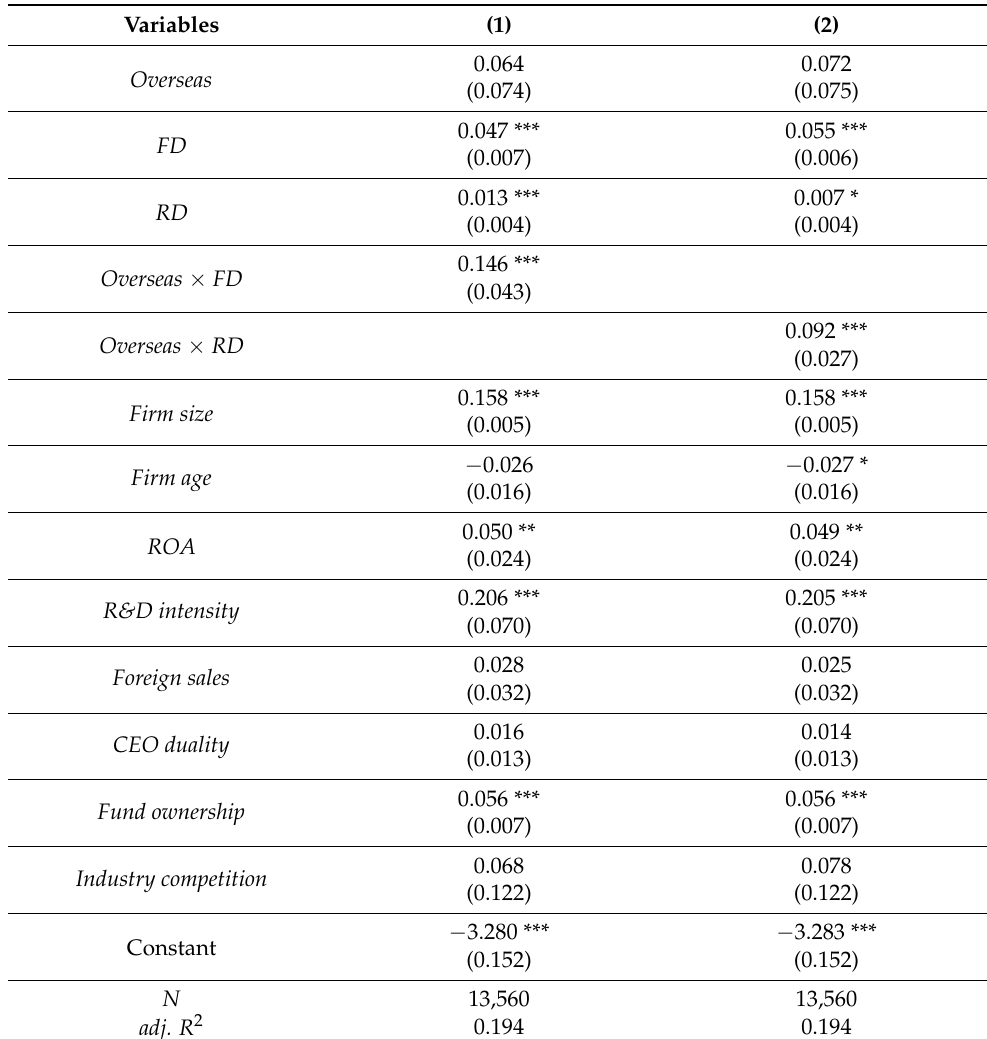
Table 5. Moderating model